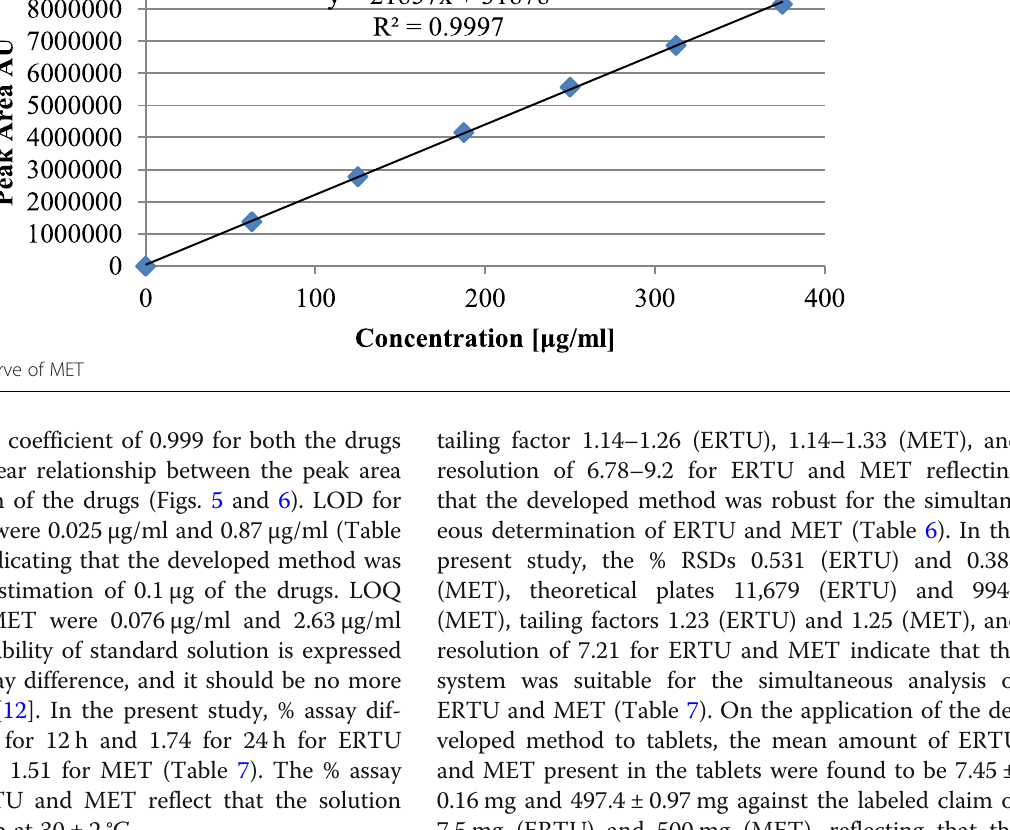
tailing factor 1.14 – 1.26 (ERTU), 1.14 – 1.33 (MET), and